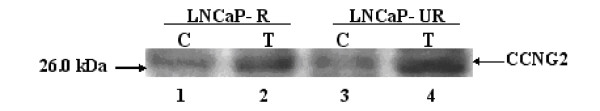
Western blot of Cyclin G2. Western blot was performed as described in Materials and Methods and shows the presence of Cyclin G2 (CCNG2) protein in LNCaP cells control or treated with 1 μM Casodex for 5 weeks. Lane 1, LNCaP-R control. Lane 2, LNCaP-R treated 5 weeks in 1 μM Casodex. Lane 3, LNCaP-UR control. Lane 4, LNCaP-UR treated 5 weeks in 1 μM Casodex.